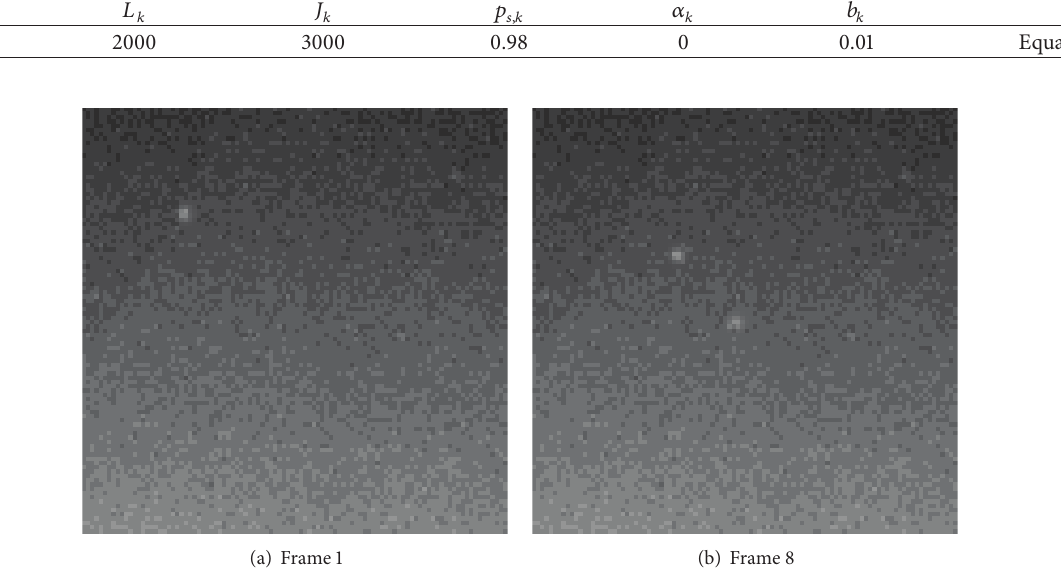
Figure 5: Two image sequences: frame 1 and frame